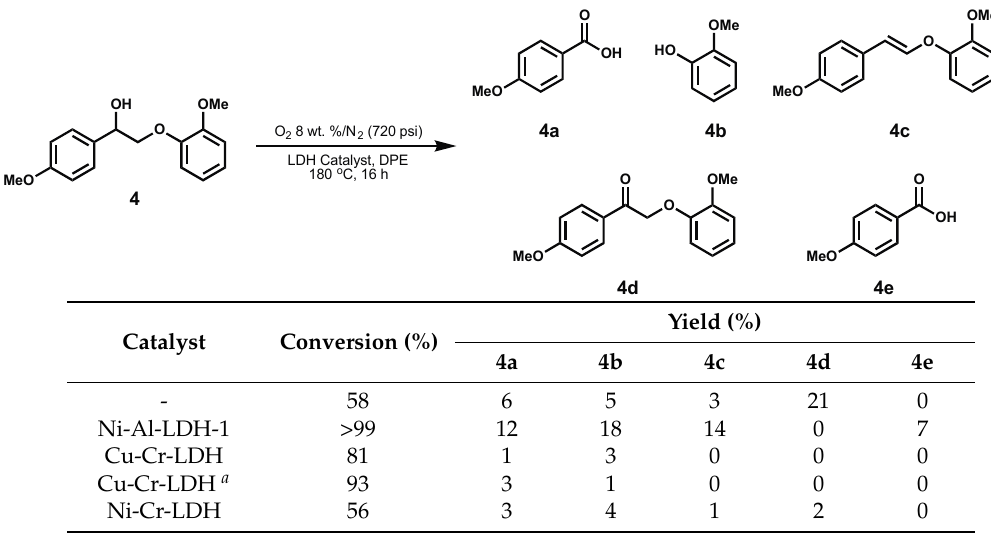
Table 9. Conversion of 4 over LDH catalysts in phenyl ether with O 2 .